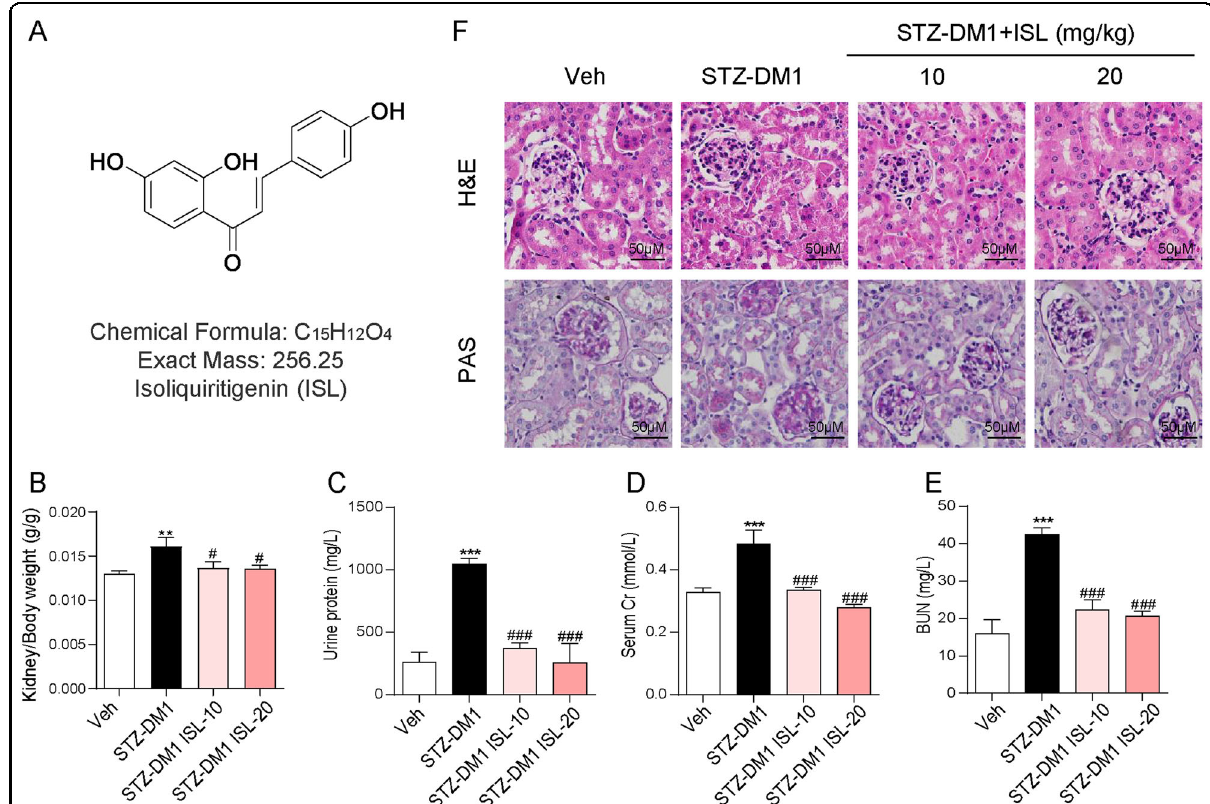
Fig. 1 ISL attenuated hyperglycemia-induced renal histological abnormalities and biochemical indicators increase. Diabetes mellitus was induced by streptozotocin (STZ), which dissolved in 0.1 mol/L sodium citrate buffer (pH 4.5) for intraperitoneal injection at 50 mg/kg/day that lasted 5 days. The mice with fasting-blood glucose levels exceeding 12 mM were considered diabetic. Diabetic mice were then subject to oral treatment using ISL (10 or 20 mg/kg) or vehicle (0.5% CMC-Na) by gavage every other day for 12 weeks ( n = 7 in each group). 24 h before the conclusion of experiment, mice urine was collected. After killing, kidney tissues of the mice were collected and blood samples centrifuged to collect serum for further analysis. a The structure of ISL. b The kidney/body weight ratio. c Total protein concentration in urine. d The level of serum creatinine. e The level of serum BUN. f Representative images for H&E staining and PAS staining using the formalin- fi xed renal tissues as described in Methods and materials (×400 magni fi cation) (A minimum of fi ve mice in each group were used for analysis. ** P < 0.01, *** P < 0.001 vs control (Veh); # P < 0.05, ### P < 0.001 vs